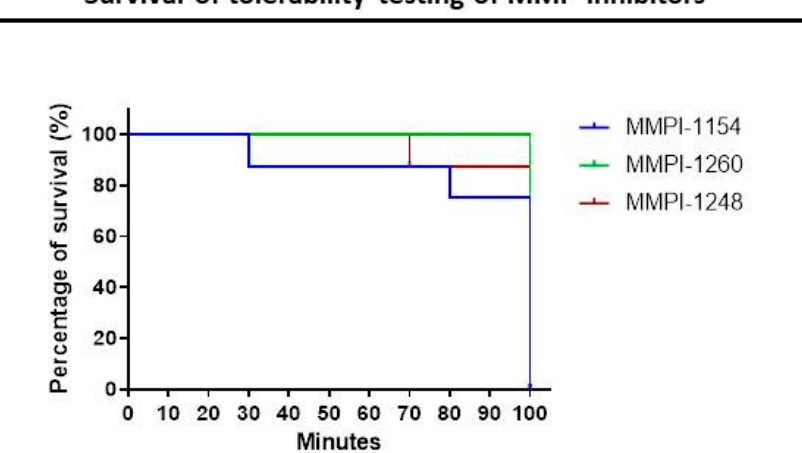
Figure 2. Kaplan-Meier curve of survival of male Wistar rats during matrix metalloproteinase inhibitor (MMPI) tolerability testing ( n = 8).